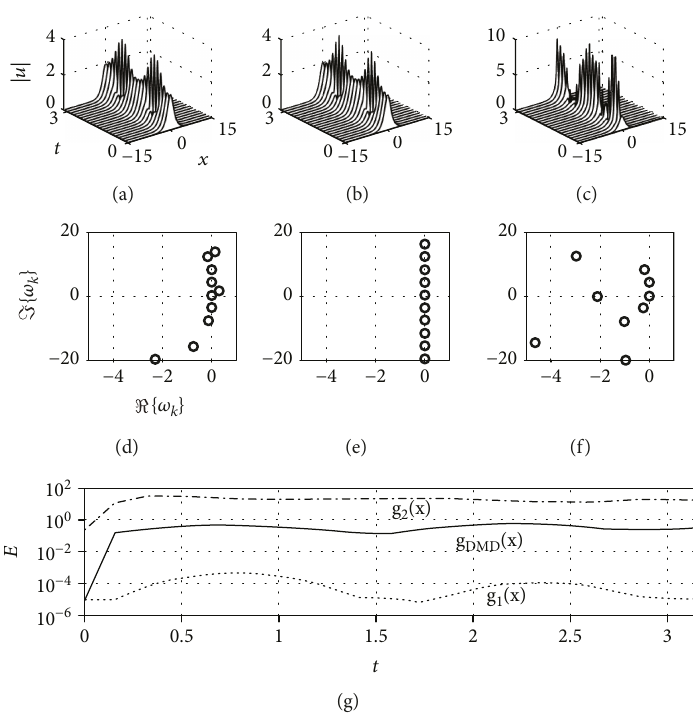
Figure 4: Reconstruction of the NLS dynamics using (a) a standard DMD approximation g x , (b) the NLS motivated g x , and (c) a DMD 1 quadratic observable g x . The Koopman spectra for each observable are demonstrated in (d), (e), and (f) which accompany the observables 2 of (a), (b), and (c), respectively. Note that the observable g x produces spectra which are approximately purely imaginary which is expected 1 of the 2-soliton evolution. The error between the three observables and the full simulation is shown (g). Note that the observable g x gives 1 an error reduction of four-orders of magnitude over DMD, while g x is an order of magnitude worse. This highlights the importance of 2 selecting good observables. The simulation was performed over t ∈ 0, π with 41 equally spaced snapshots taken. The domain was discretized with n = 512 points on a domain x ∈ − 15, 15